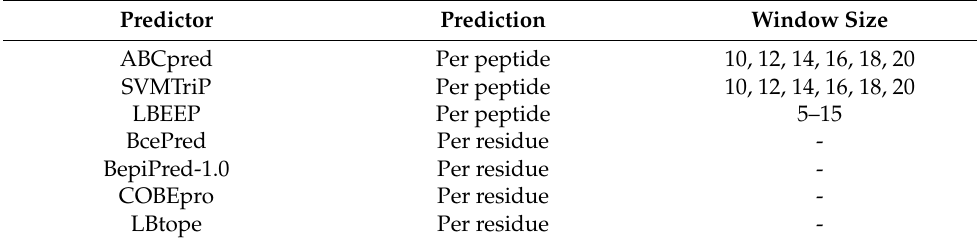
Table 3. Input window sizes and prediction approach of each method. The classification of query proteins as epitopes can generally be performed in either a “per residue” or a “per peptide” basis. In the “per residue” methods each separate residue of a protein is assigned an antigenicity score, while in the “per peptide” methods, a prediction is limited within fixed windows